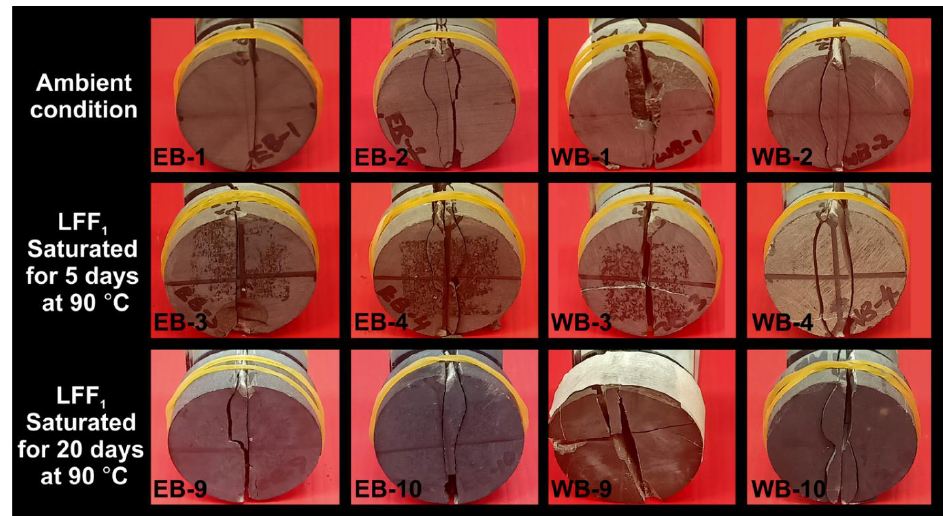
Figure 16. Failure patterns resulting from samples subjected to different treatment conditions prior to BITS testing. The Wolfcamp sample WB-6 at a percentage increase in mass (0.06%) had the highest tensile strength (11.44 MPa), seconded by WB-5 at 11.32 MPa, with a percentage increase in mass of 0.11% based on LFF 2 saturation at 90 °C (Figure 17a,b). Then, the Eagle Ford shale sample EB-12 had the lowest tensile strength at 5.19 MPa, with a percentage increase in mass of 0.48%. As evident in Figure 17a,b, the Eagle Ford samples, in comparison to the Wolfcamp samples, were more associated with higher values of percentage increase in mass and lower values of tensile strength. Figure 17c represented the ATSs of sample sets subjected to different treatment con- ditions prior to BITS testing. ATS increase was recorded from 7.52 MPa, for ambient Wolfcamp samples WB-1 & 2, to 11.38 MPa, for samples WB-5 & 6. This represented an increase of 51.33% in the ATS following LFF 2 saturation at 90 °C for 5 days. WB-11 & 12 saturated with LFF 2 at 90 °C for 20 days recorded an ATS value of 9.50 MPa. This repre- sented an increase of 26.33% with reference to the ATS of ambient samples WB-1 & 2. LFF 2 saturation of the Wolfcamp samples WB-5 & 6 for 5 days and WB-11 & 12 for 20 days at 90 °C led to 51.33 and 26.33% increases in ATS, respectively. These increases were associ- ated with an APIM value of 0.08% for WB-5 & 6 under 5 days and of 0.15% for WB-11 & 12 under 20 days of LFF 2 saturation at 90 °C (Figure 17d). It should be noted that, at the lower value of APIM, the ATS was higher at 11.38 MPa for WB-5 & 6, and then, at the higher value of APIM, the ATS was at a lower value (9.50 MPa) for WB-11 & 12. This implied that the higher absorption of LFF 2 at 90 °C, as reflected by the APIM value (0.15%), induced ATS lowering tendencies on WB-11 & 12 in comparison to the ATS of WB-5 & 6. Thus, the higher fluid saturation level has the potential of gradual reduction of the LFF 2 adhesive property, weakening the cohesive bonding of rock materials, and, in effect, lead to some tensile strength reductions.